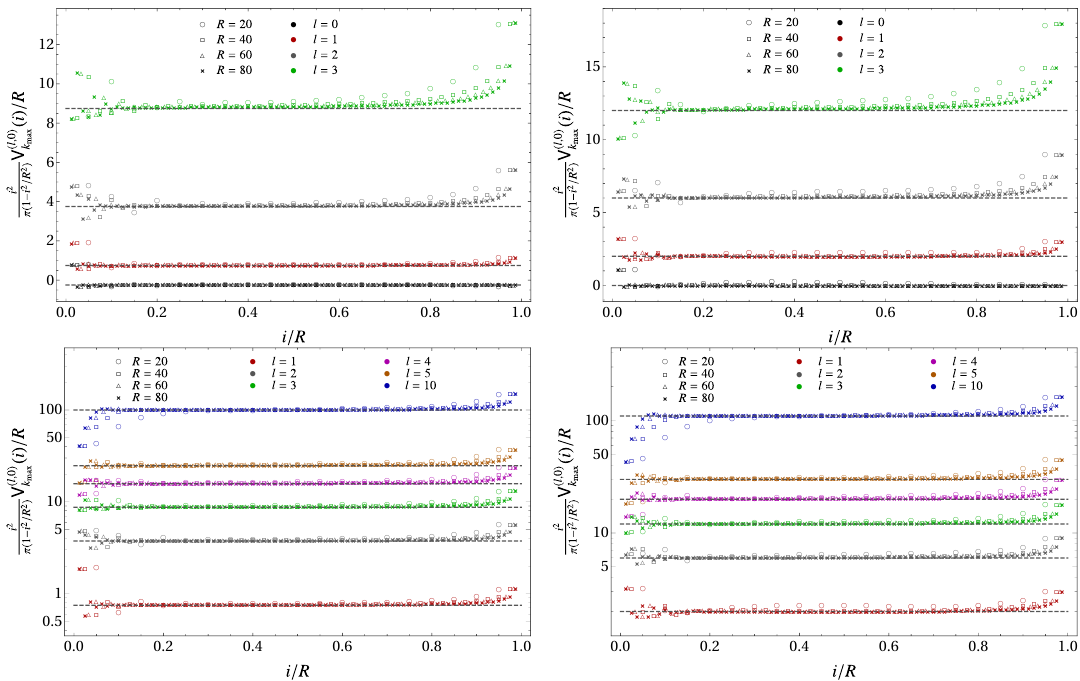
Figure 4. V ( l, 0) /R from (3.18) when ω = 0 and either d = 2 (left panels) or d = 3 (right panels), k max for small values of l and k = R/ 10 for every l (other choices for k have been considered in max max figure 15). The horizontal dashed lines correspond to (2.11), i.e. to l 2 − 1 / 4 in the left panels and to l ( l +1) in the right panels. In the bottom panels the data corresponding to 1 6 l 6 10 are shown by adopting the logarithmic scale for the vertical